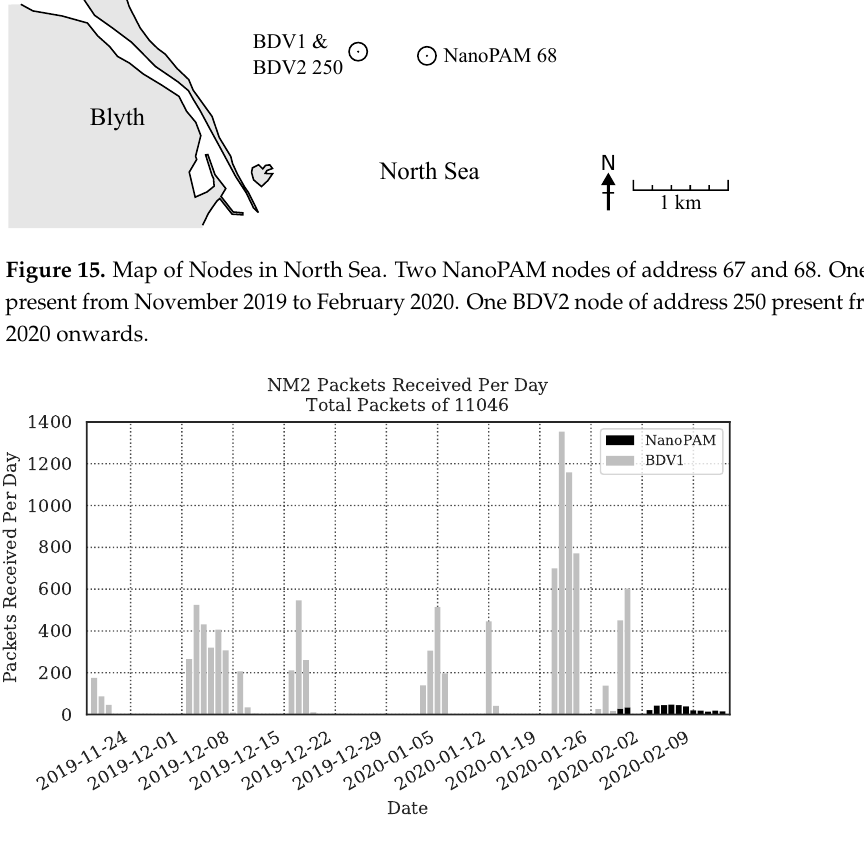
Figure 16. NM packets received per day. Mid-winter solar levels being low meant that there were periods where the buoy was powered